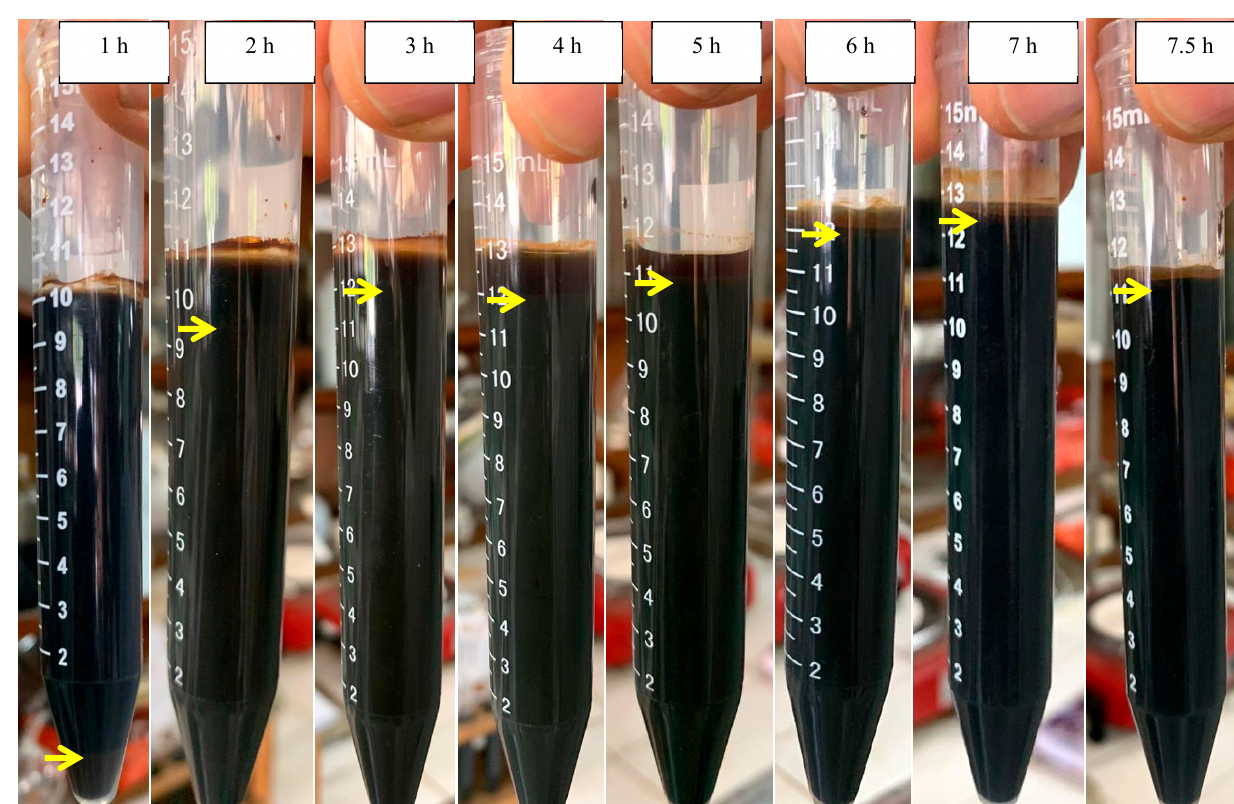
Water 2020 , 12 , x FOR PEER REVIEW